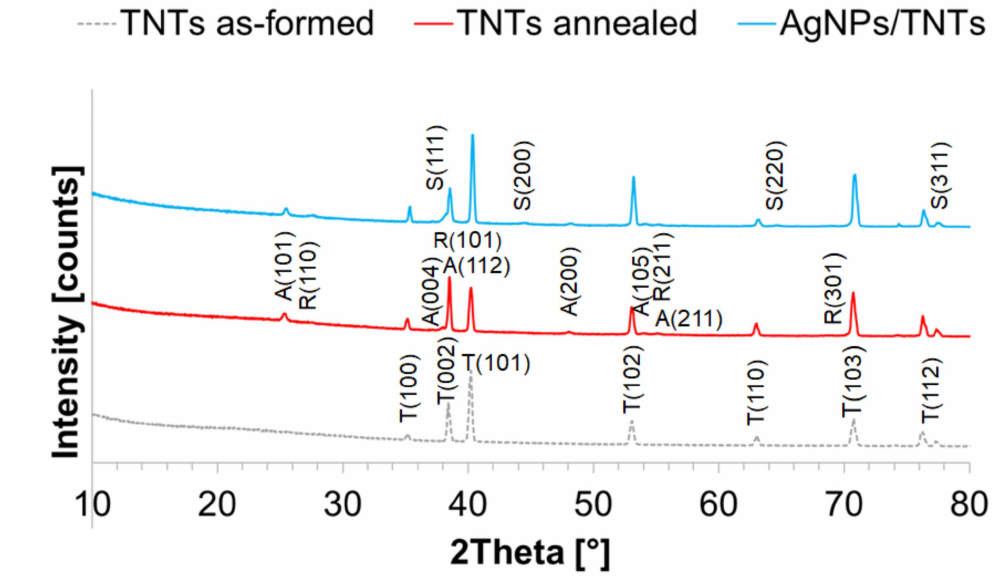
Figure 4. X-ray diffraction patterns of as-formed TNTs, annealed TNTs, and AgNPs/TNTs platform. XRD diffractograms for AgNPs/TNTs, apart from the peaks derived from titanium substrate and TiO 2 in anatase and rutile phase, showed the peaks for silver in the metallic form. The main silver diffraction peak (111—face-centered (fcc) cubic crystal lattice), which overlaps with both the peak for titanium (002) and anatase (112), reaches its